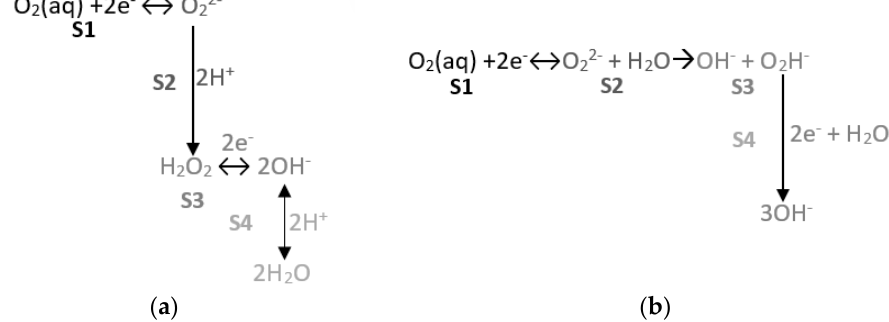
Figure 14. ( a ) Reaction of O 2 reduction in acid/neutral medium. ( b ) Reaction of O 2 reduction in basic medium. S: Stages of the O 2 reduction reaction.